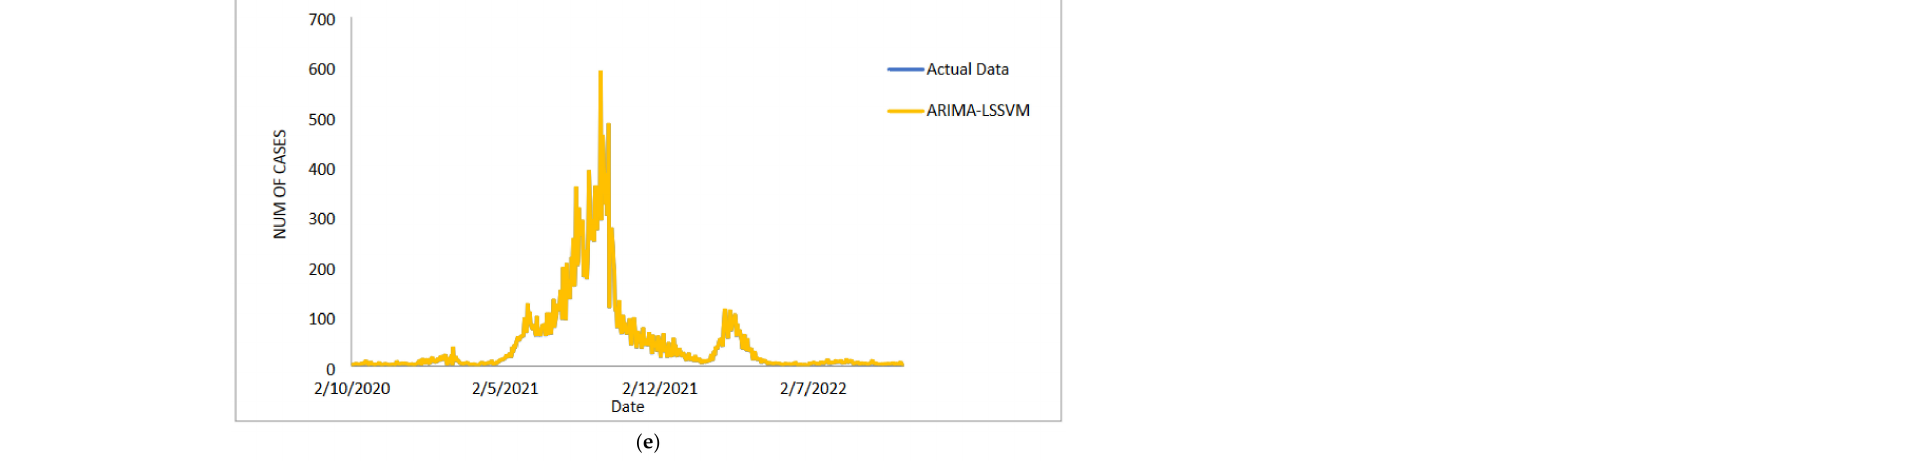
Figure 7. Results obtained from the proposed model for daily new death COVID-19 cases dataset: ( a ) actual data vs. ARIMA model, ( b ) actual data vs. LSSVM models, ( c ) actual data vs. SVM model, ( d ) actual data vs. ARIMA–SVM models, ( e ) actual data vs. ARIMA–LSSVM models.